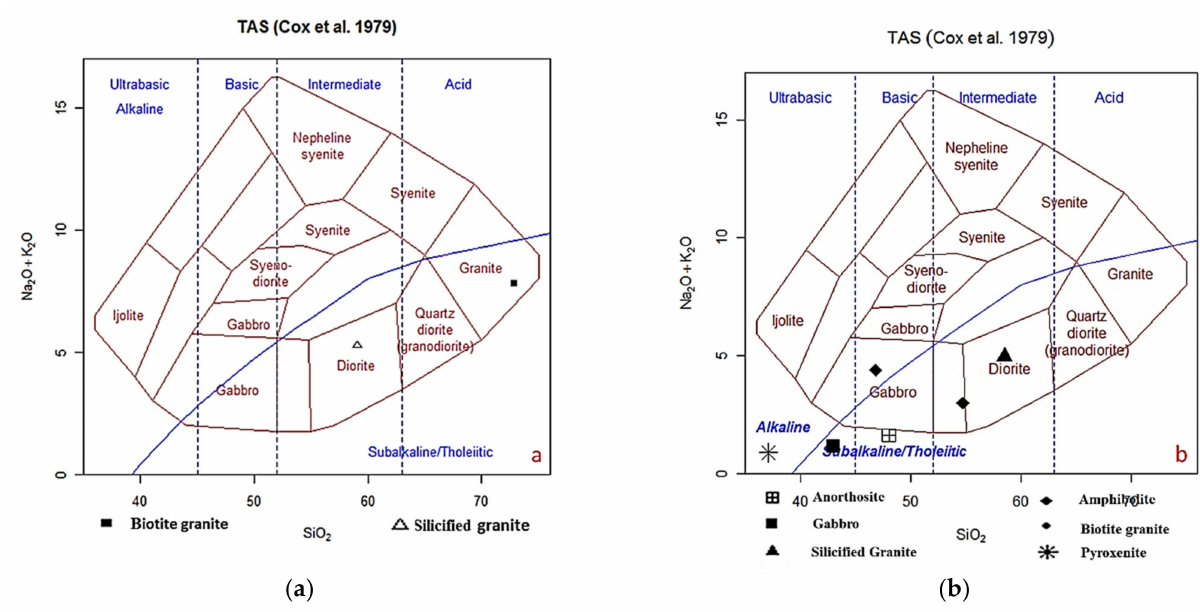
Figure 7. ( a ) Discrimination plots between SiO 2 (wt %) and Na 2 O + K 2 O (wt %) of granitoid rock.